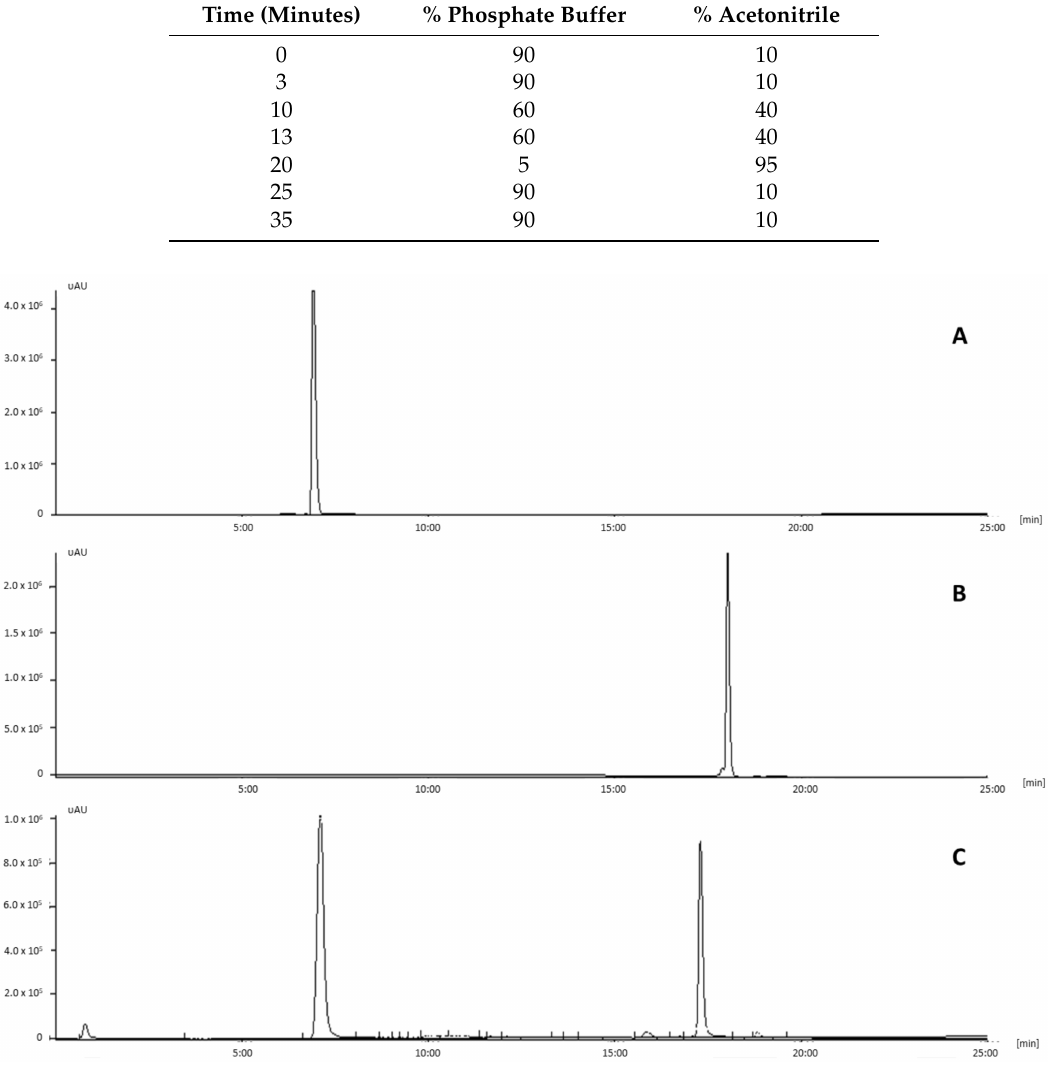
Table A1. HPLC analysis for 1a . XTerra RP18 column (3.5 µ m, 4.6 × 50 mm). Flow rate: 1 mL/min.